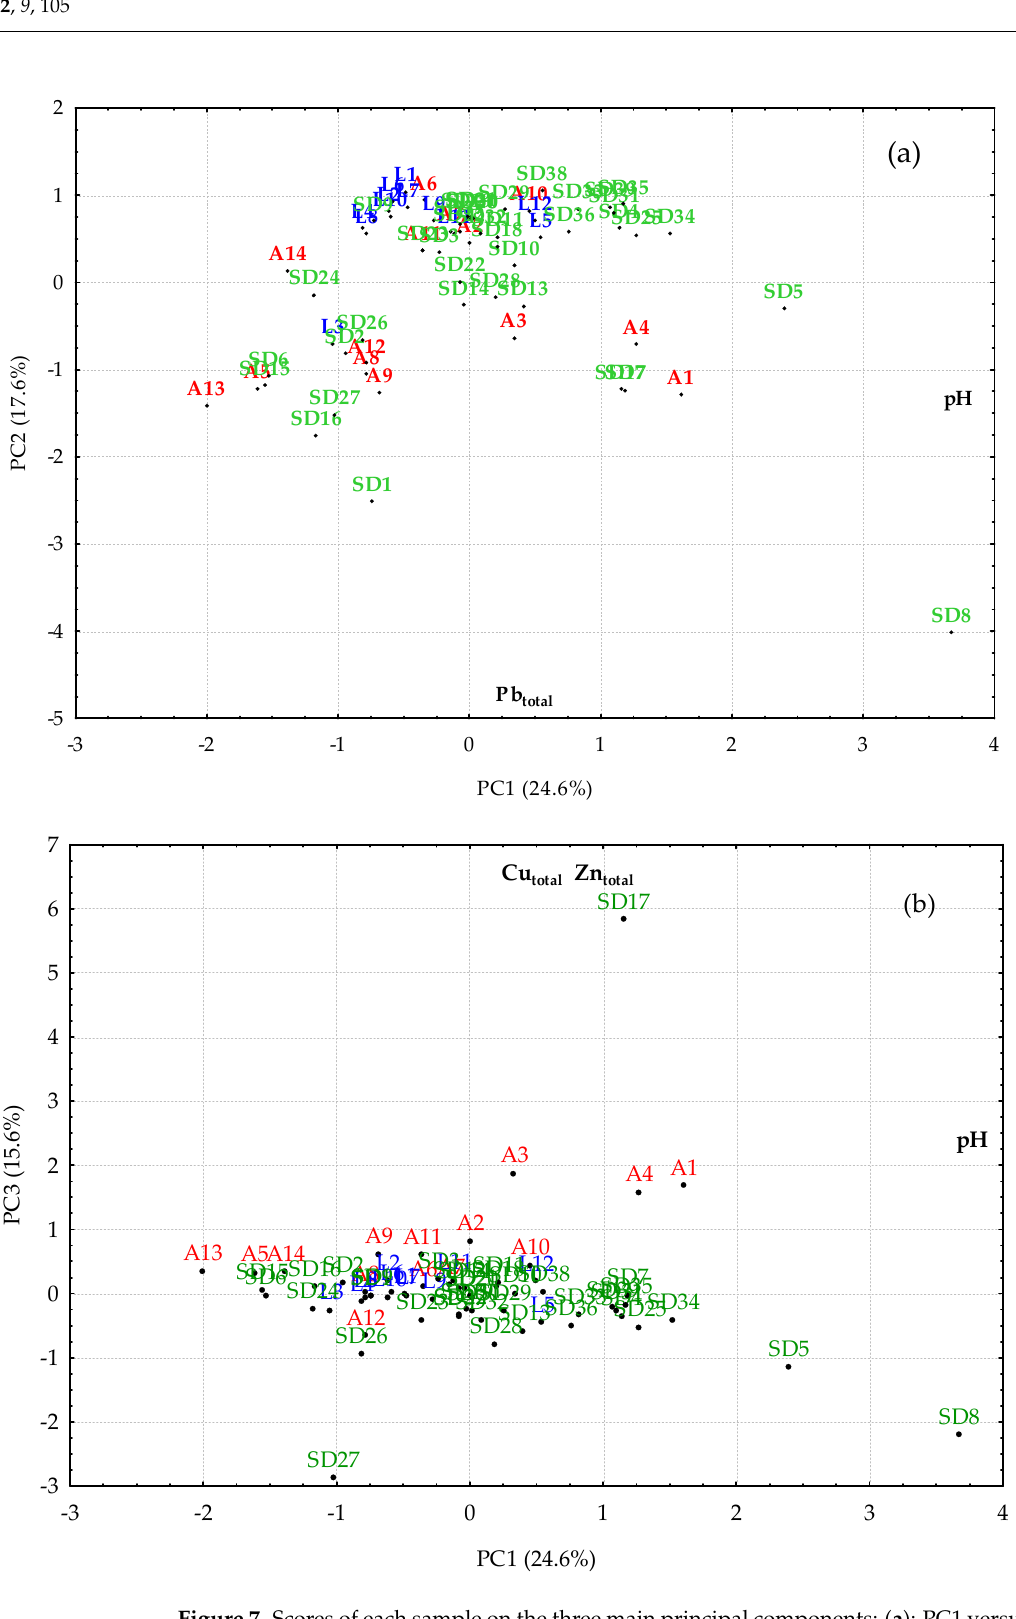
Figure 7. Scores of each sample on the three main principal components: ( a ): PC1 versus PC2; ( b ) PC1 versus PC3. The most important parameters for the definition of the two components are shown on the edge of each axis, indicating the direction in which the value of the parameter increases (pH: soil pH(H 2 O); and Cu total , Pb total and Zn total : pseudo-total elements concentration aqua-regia digestion). The color of the label indicates the mine: red for Aljustrel; blue for Lousal; and green for São Domingos.